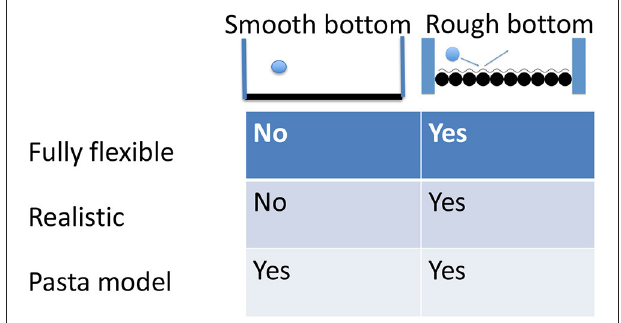
FIGURE 9 | Phase diagram for the different simulation conditions and whether they produce a